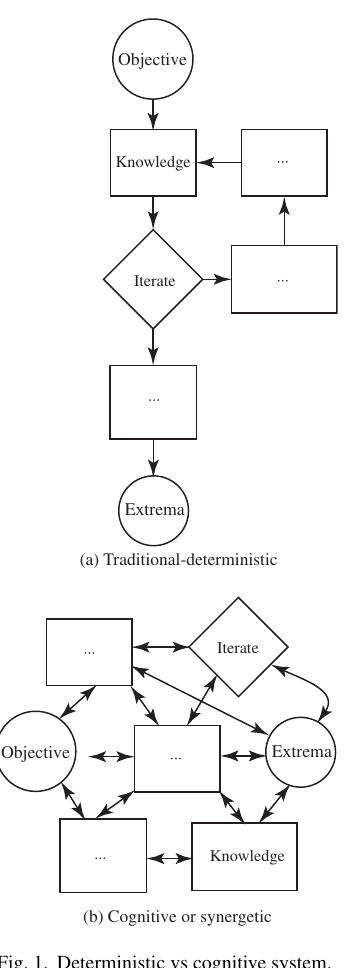
Fig. 1. Deterministic vs cognitive